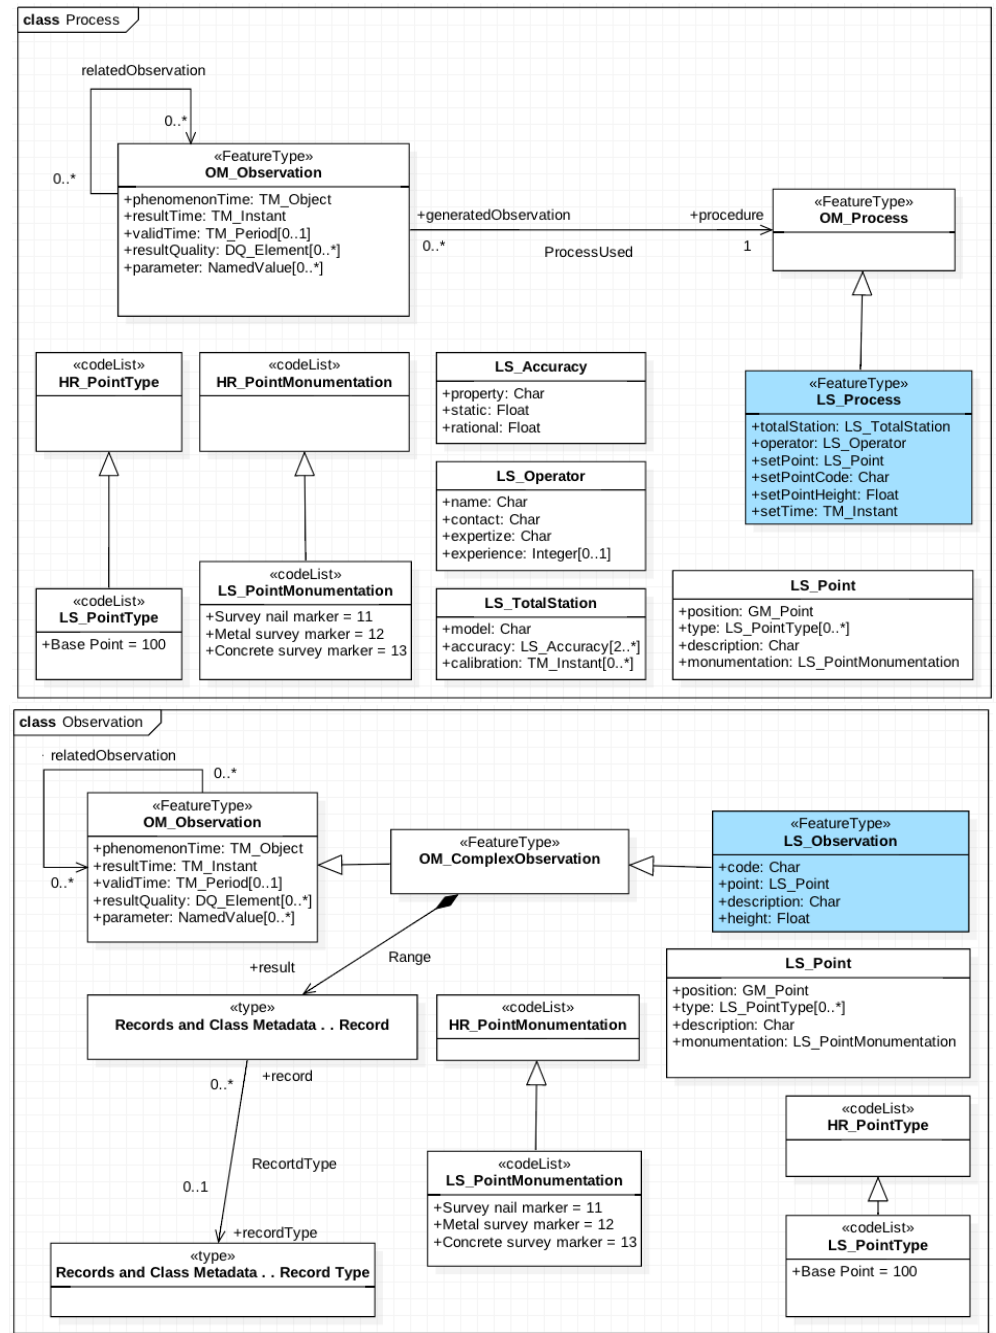
Figure 4: a) OM inherited process model, b) OM inherited observation model.